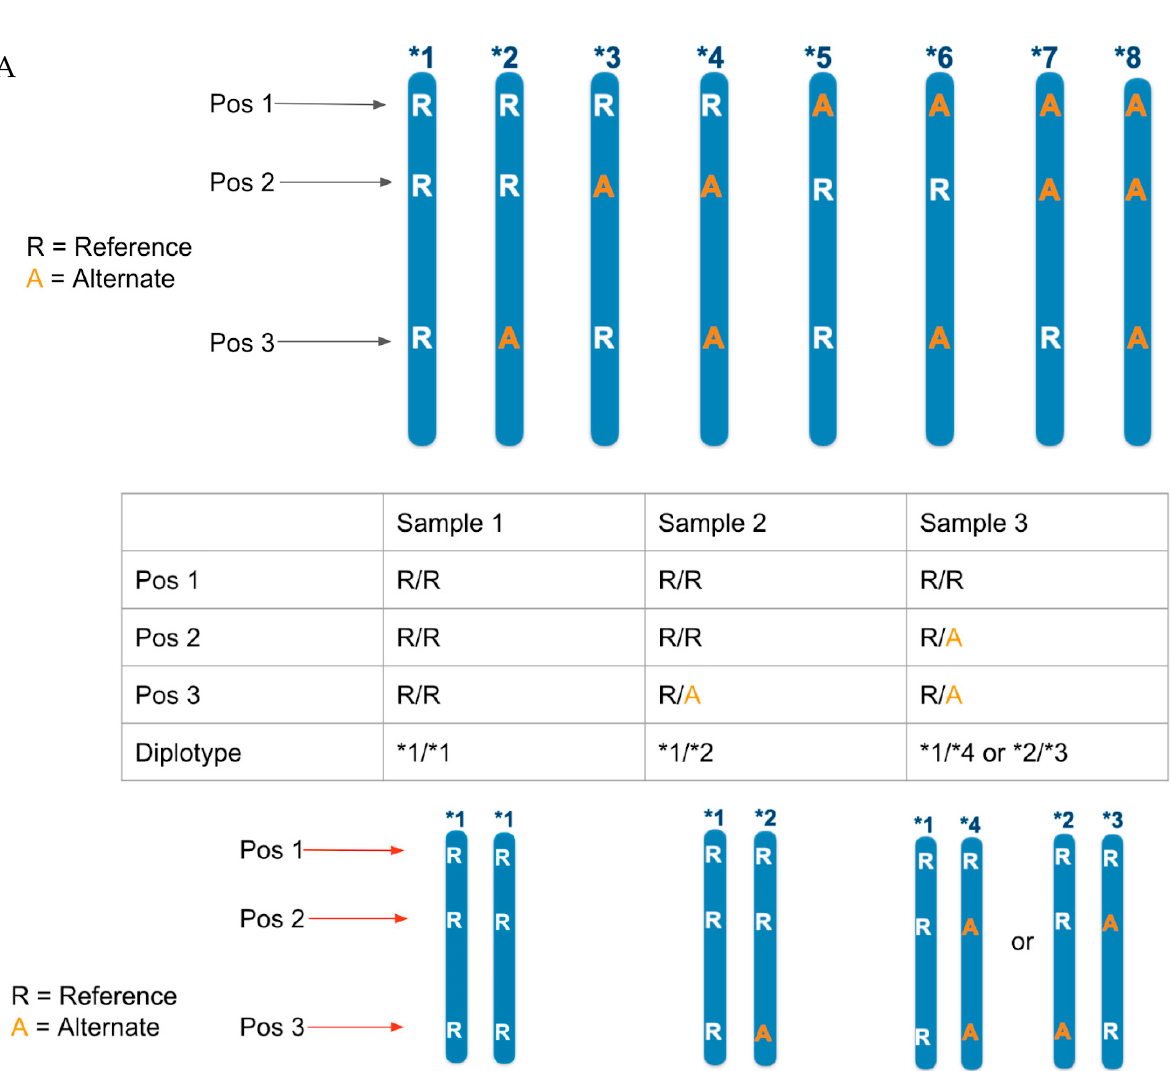
Figure 1 . Description of multi-variant star alleles. ( A ) Possible star allele haplotypes at a genomic region. ( B ) Possible star allele diplotypes at a genomic region.